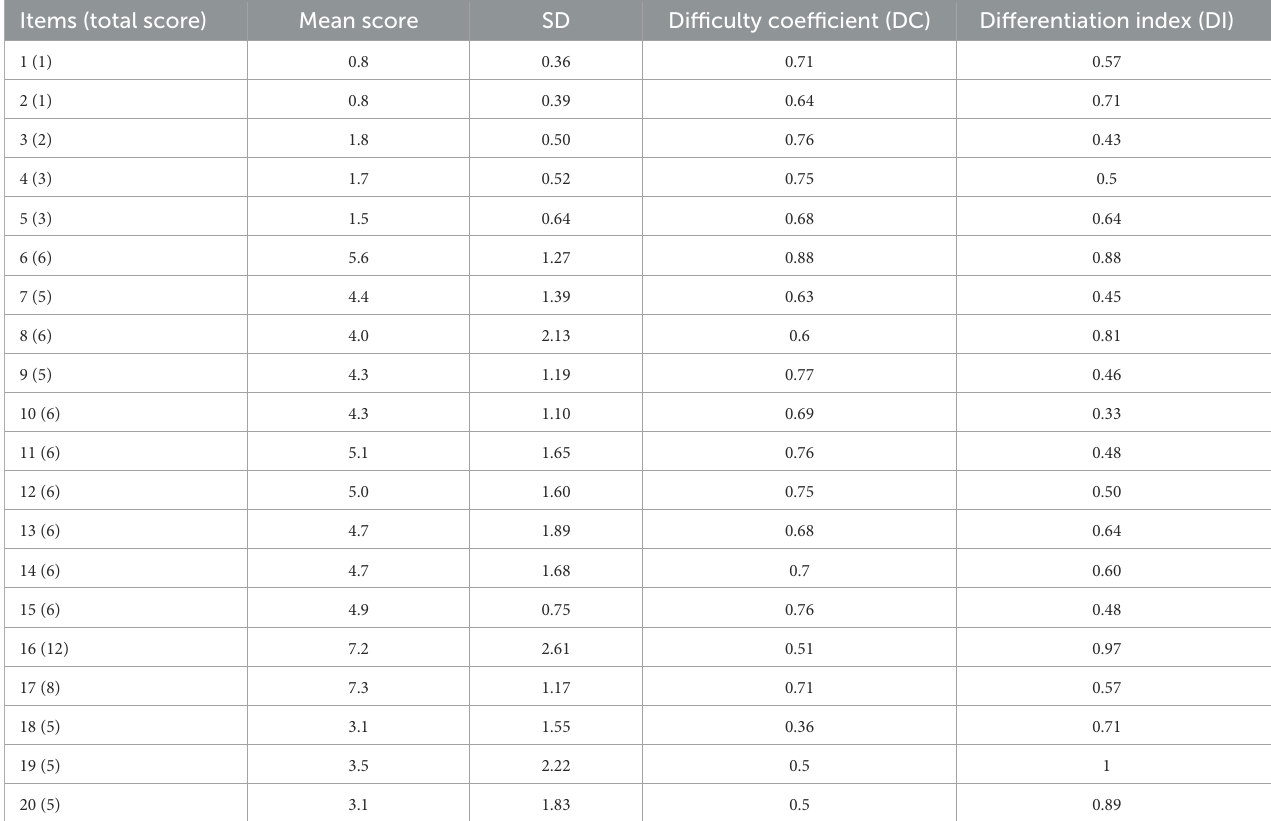
TABLE 3 Checklist item performance averages of difficulty coefficient and differentiation index for all participants. Items (total score)